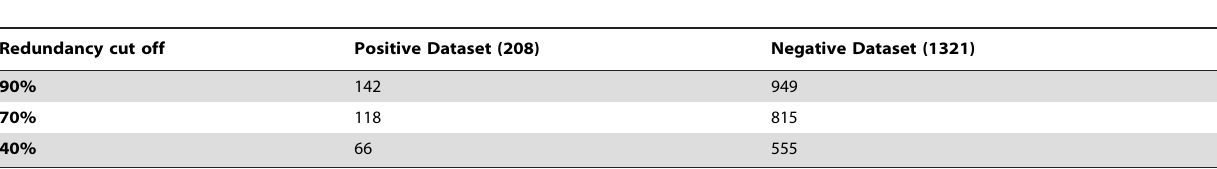
Table 1. Number of protein sequences after removing redundant proteins at thresholds of 90%, 70% and 40% using